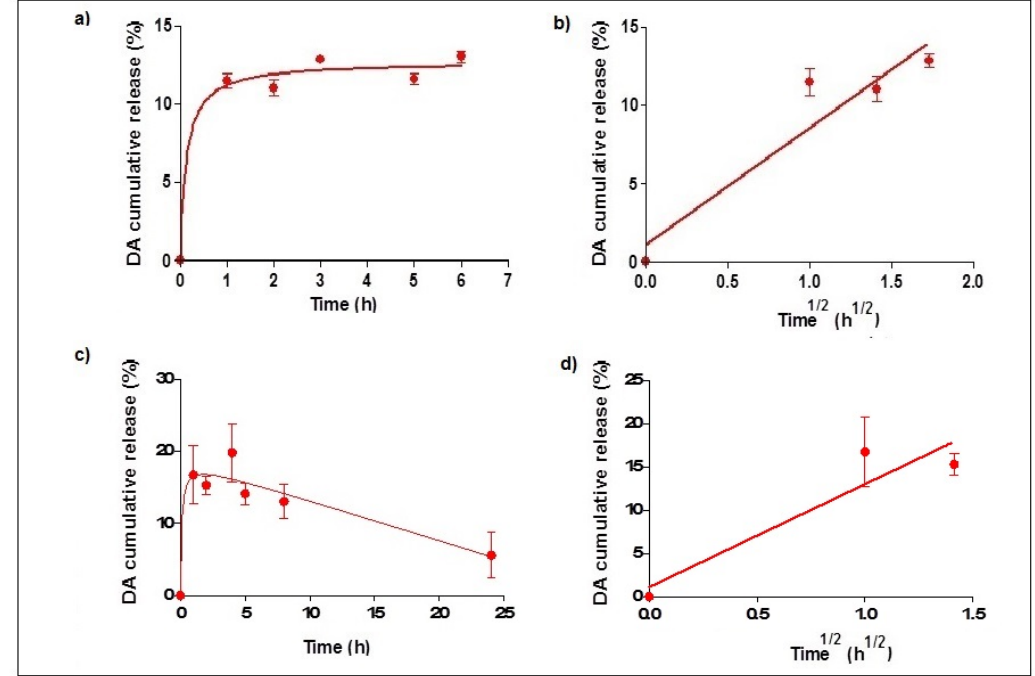
Figure 11. ( a ) DA cumulative release in SNF from AlgOX-DA imine conjugate; ( b ) square root dependency of DA released in SNF from AlgOX-DA imine conjugate; ( c ) DA cumulative release in PBS (pH = 7.4) from AlgOX-DA imine conjugate; ( d ) square root dependency of DA released in PBS (pH = 7.4) from AlgOX-DA imine conjugate.